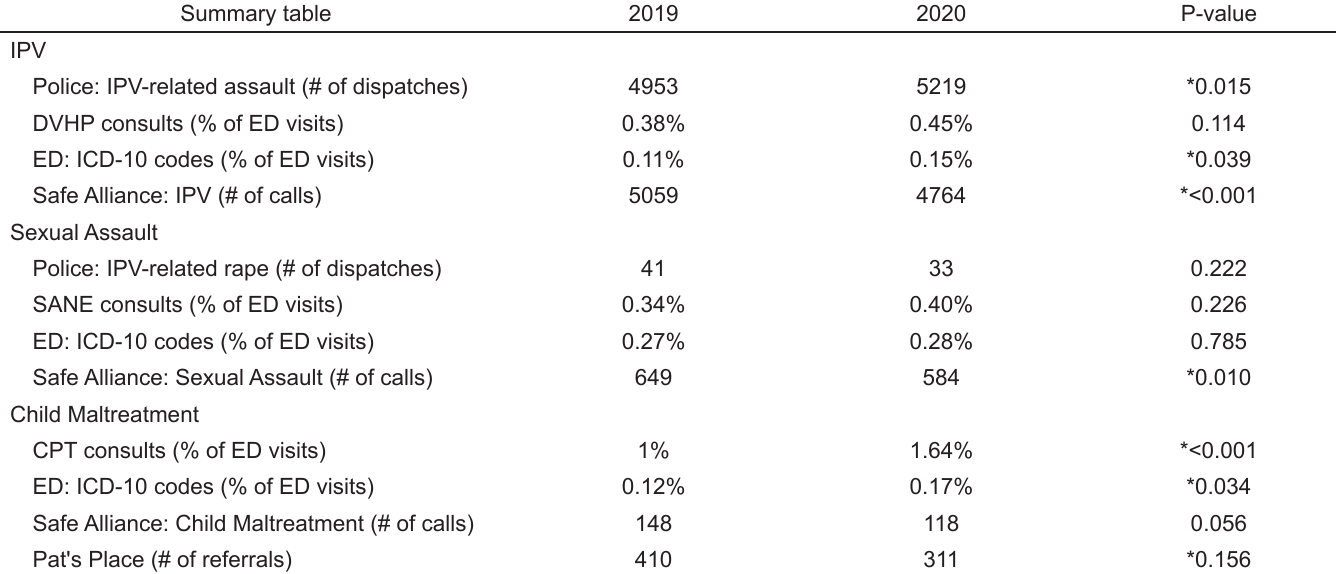
Table 3. Summary of trends rates of various types of reports of intimate partner violence, sexual assault, and child maltreatment